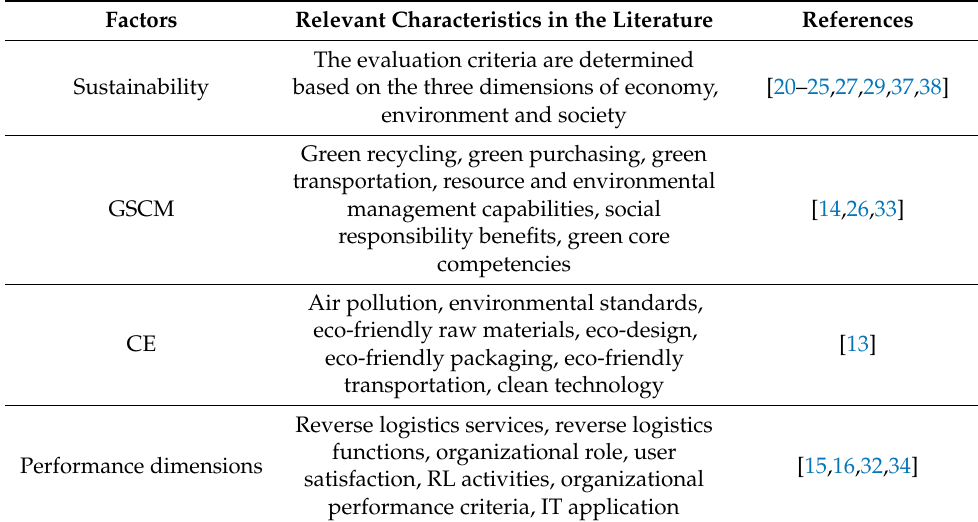
Table 1. Summary of factors for reverse logistics (RL) provider